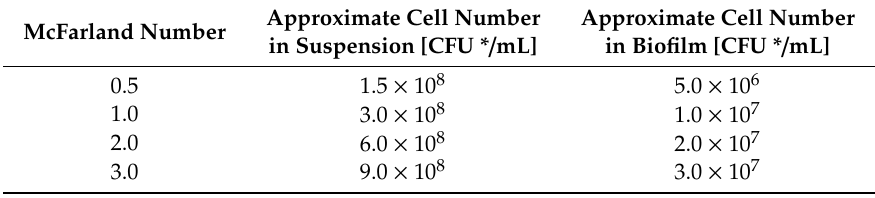
*CFU: colony-forming unit.